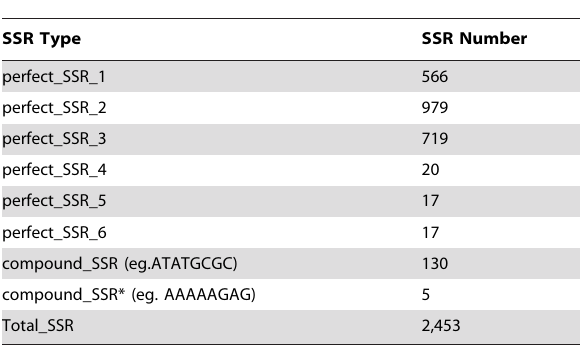
Table 5. EST-SSRs of Salvia splendens